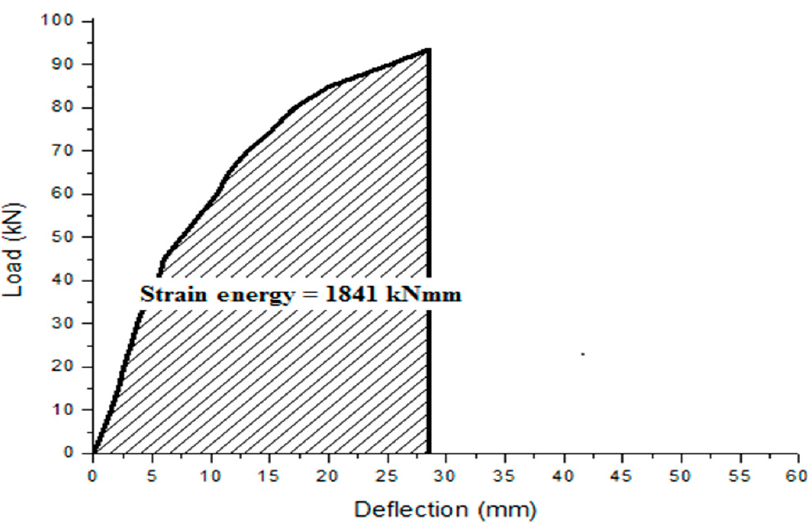
Figure 14. Strain energy for dovetailed profiled composite slab—Trial I.